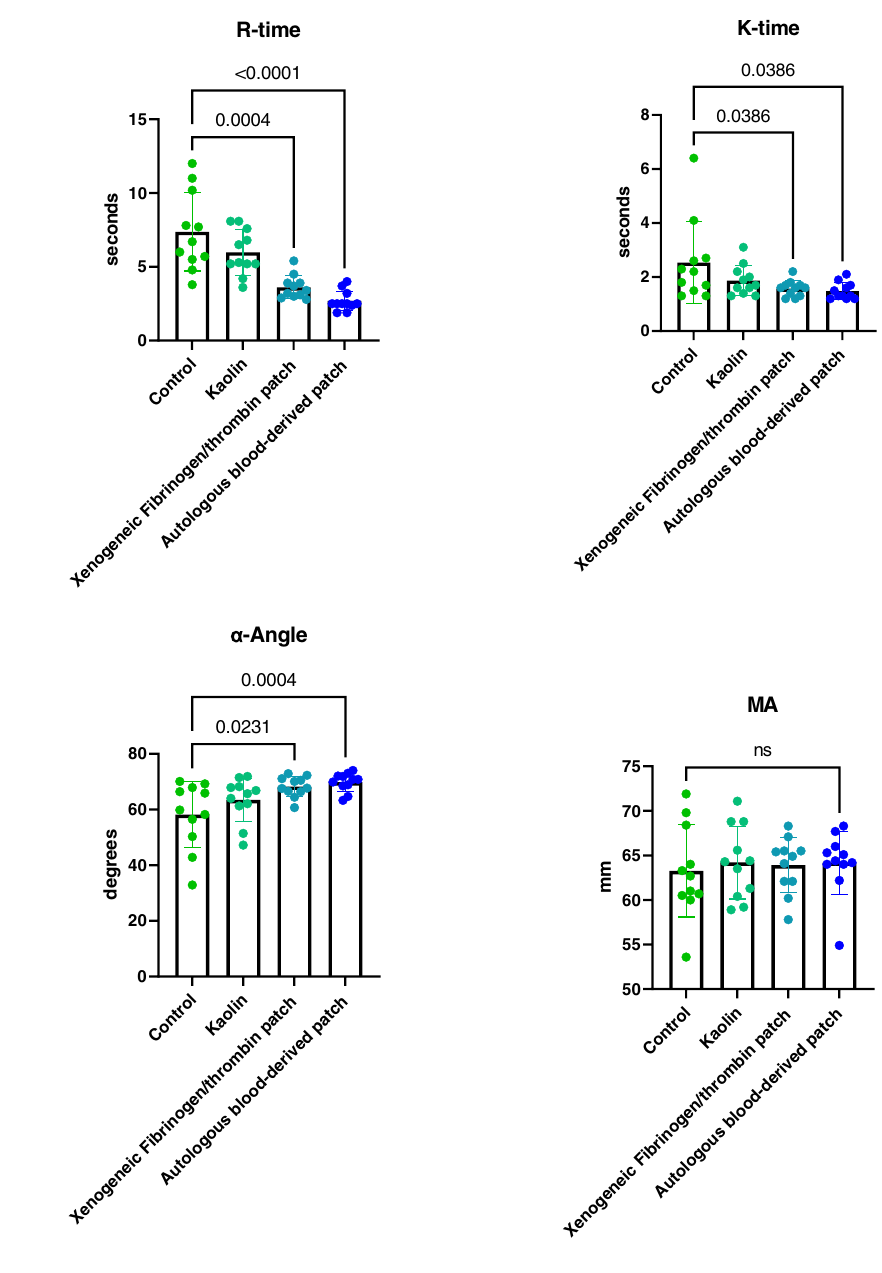
Fig. 4 Comparison of thromboelastography results in donated human blood. Both the autologous blood-derived patch and the xenogeneic fi brinogen/ thrombin patch decreased the R -time and the K -time, and signi fi cantly increased the α -Angle of the blood when compared to the non-activated blood. There was no signi fi cant difference in MA or LY30 (LY30-graph not shown). ns not signi fi